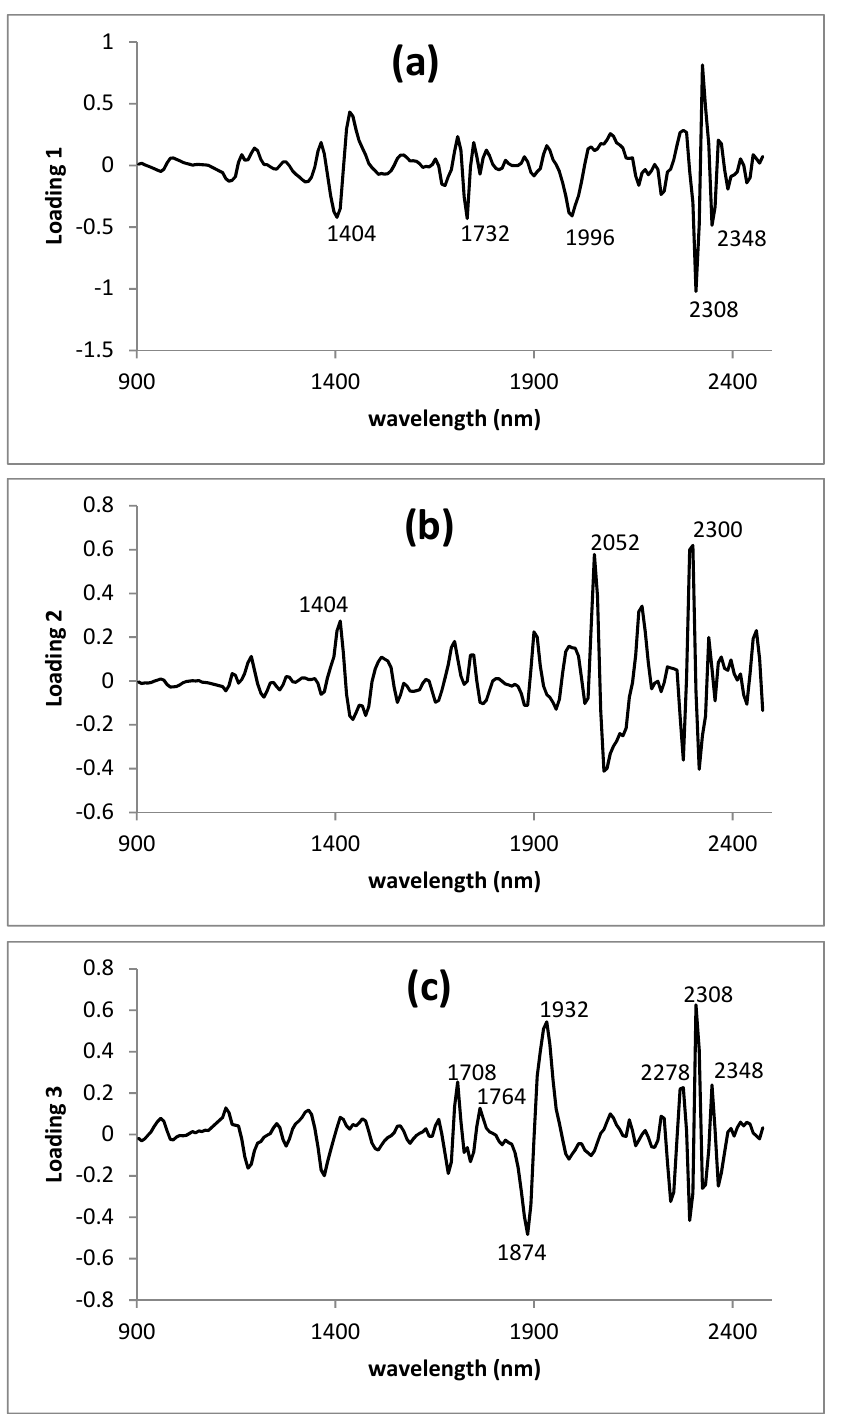
Figure 6. MPLS loading spectra for ADF in Brassica rapa in the second derivative (2, 5, 5, 2) transformations. Panels ( a ), ( b ) and ( c ) represent loadings for factors 1, 2 and 3,